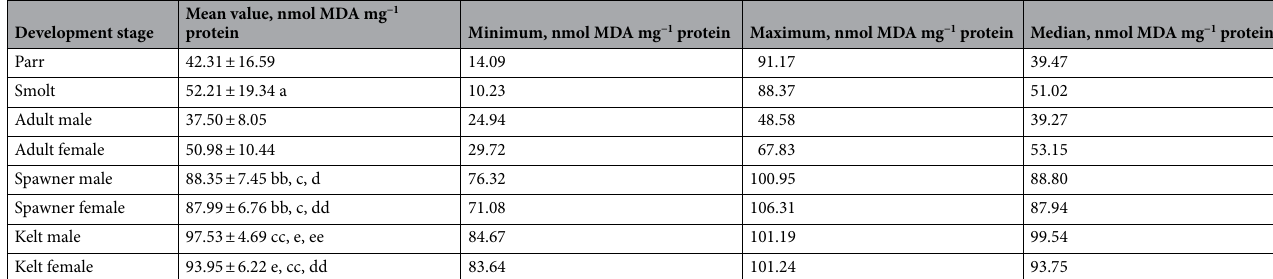
Table 1. TBARS products (nmol MDA mg −1 protein) in the muscle tissue of sea trout ( Salmo trutta m. trutta L.) during different developmental